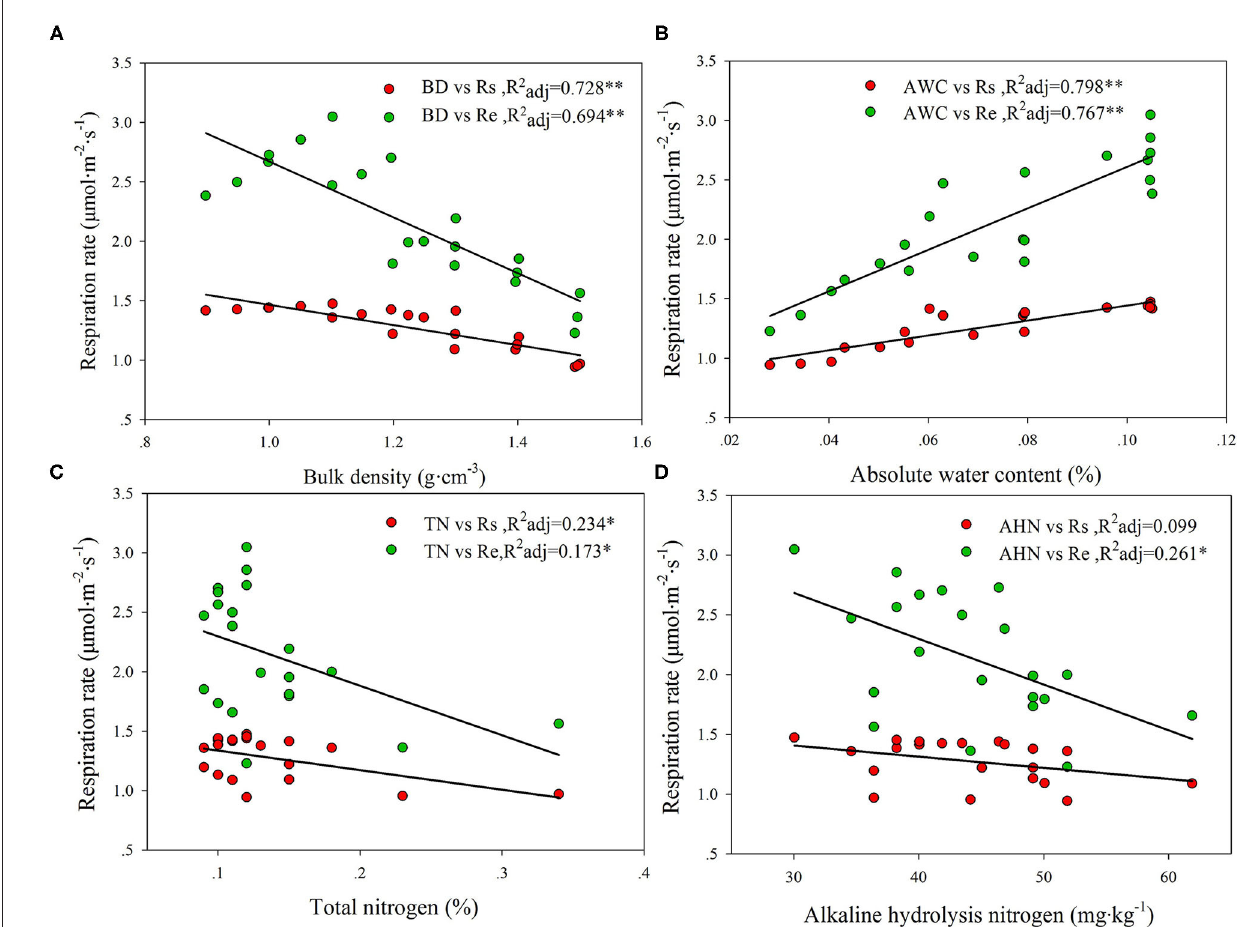
FIGURE 8 | Relationships between the (A) bulk density, (B) absolute water content (AWC), (C) total nitrogen (TN), (D) alkaline hydrolysis nitrogen (AHN), and Rs and Re. * p < 0.05 and ** p <